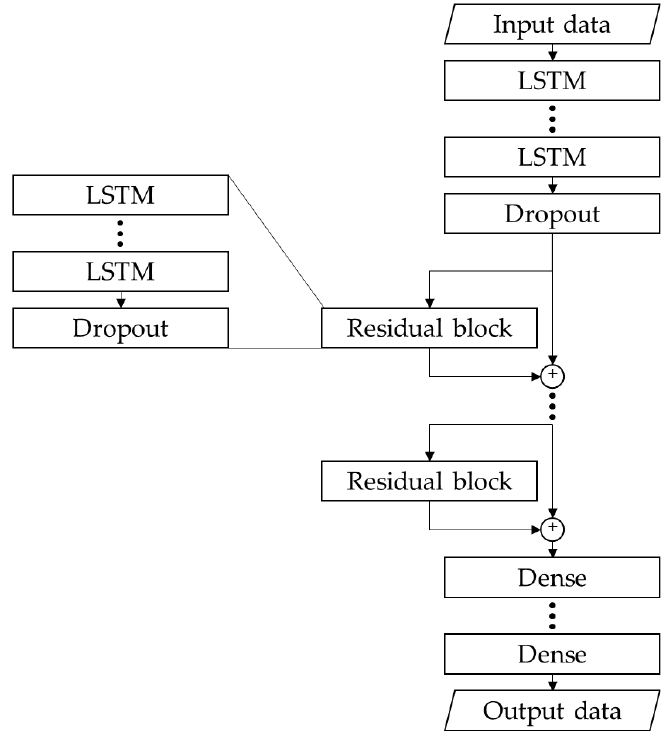
Figure 1. Architecture of residual